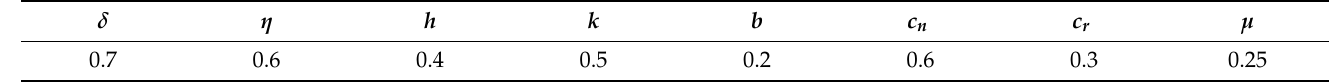
Table 5. Simulation parameter assignment.